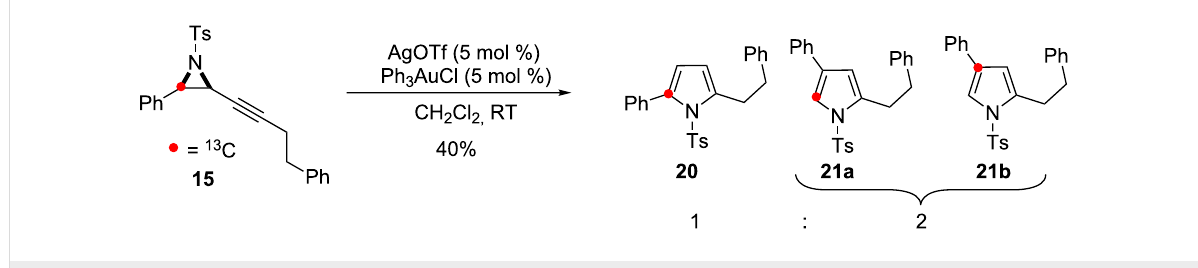
Scheme 10: Cycloisomerisation of 15 in the skeletal rearrangement reaction.